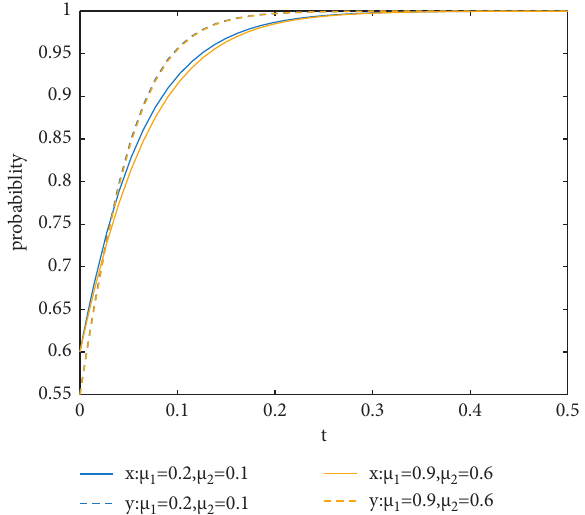
Figure 7: The effect of collaborative innovation ability on knowledge hiding.